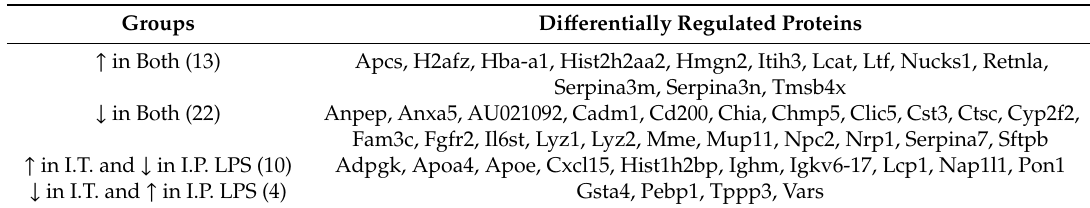
Table 1. Di ff erentially regulated BALF proteins by I.T. and I.P. LPS compared to the controls. Groups Di ff erentially Regulated Proteins